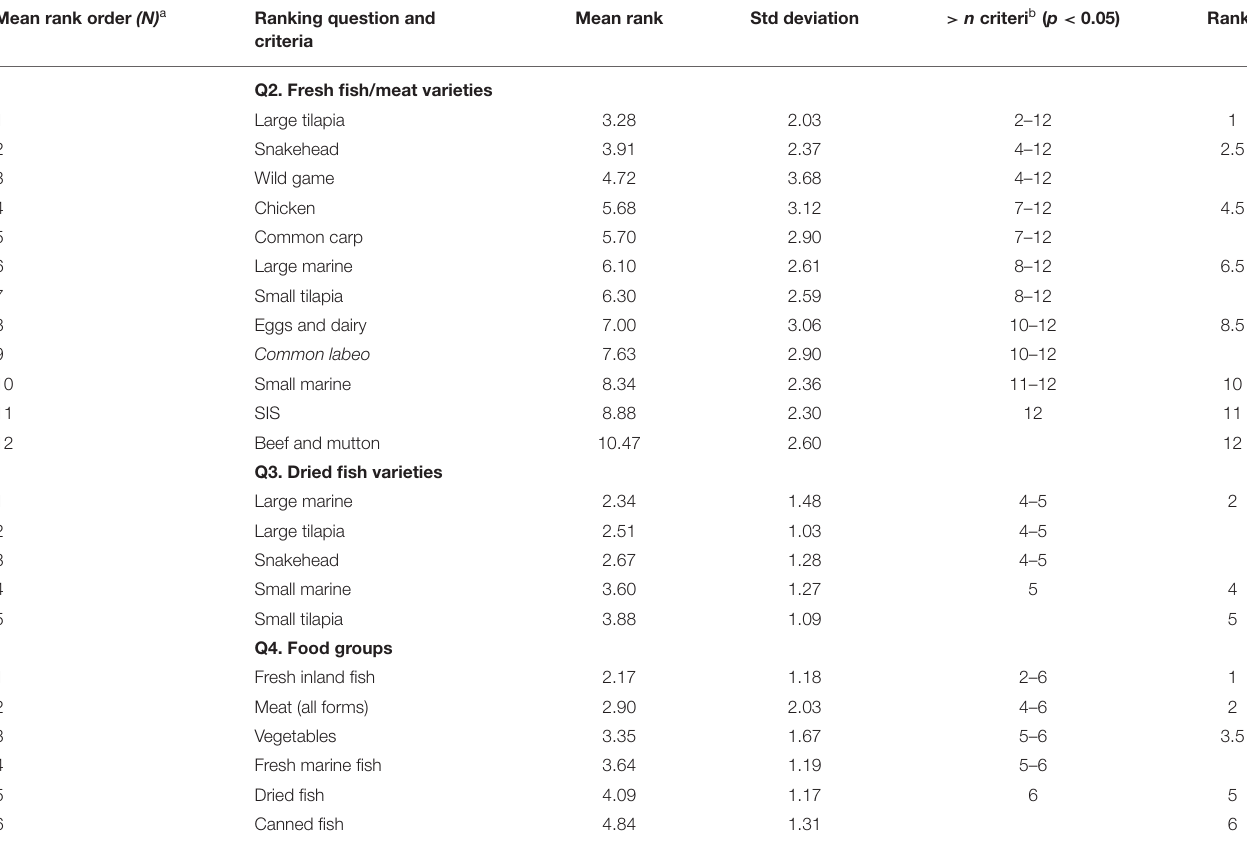
TABLE 7 | Overall ranks and descriptive statistics from pair-wise tests on preference ranks for all responses to questions 2, 3 and 4. Mean rank order (N) a Ranking question and Mean rank Std criteria